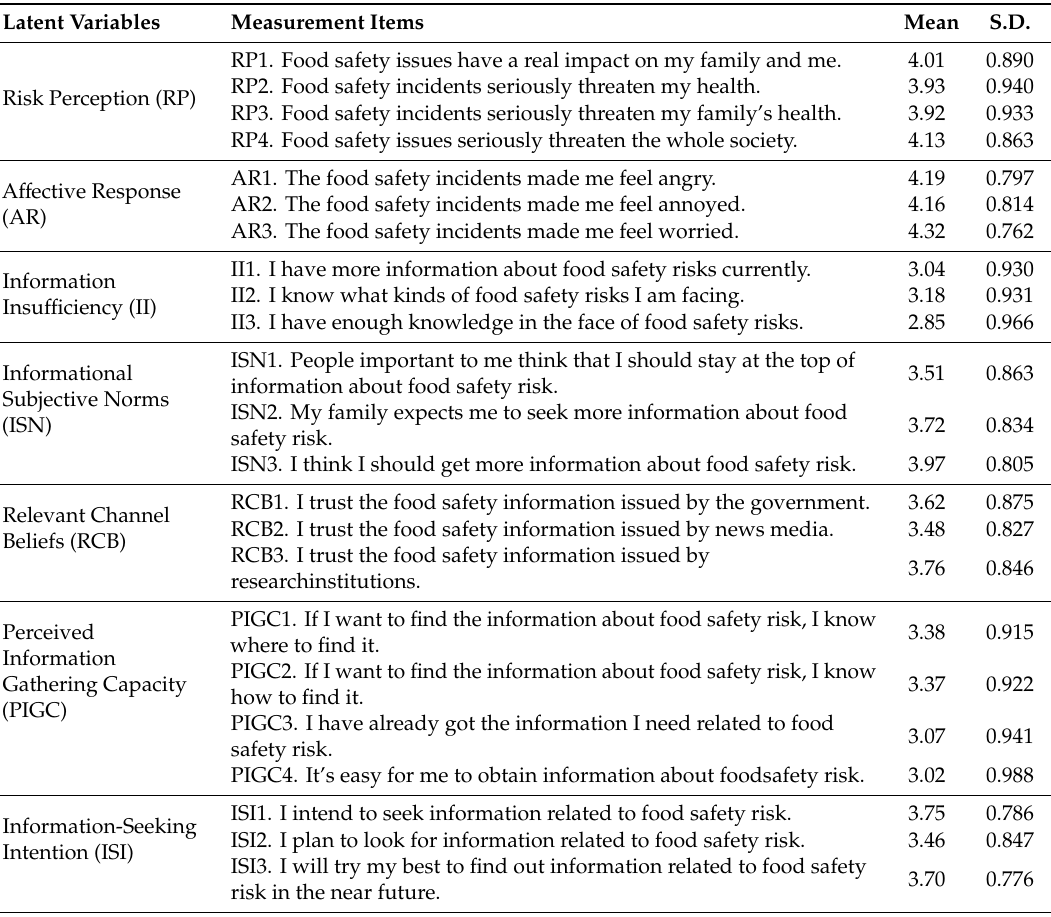
Table 1. Scale design and descriptive